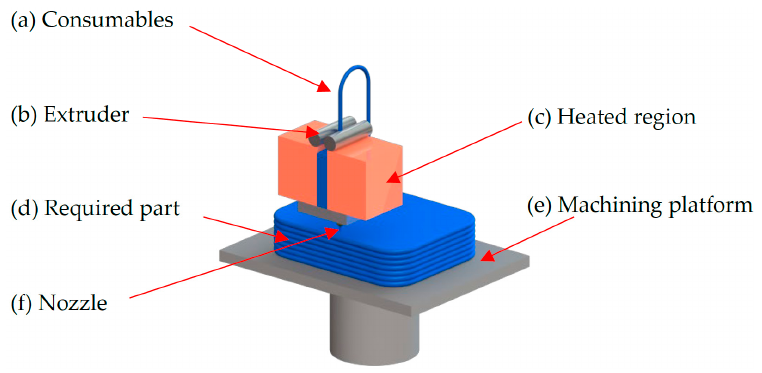
Figure 7. Schematic diagram of FDM.